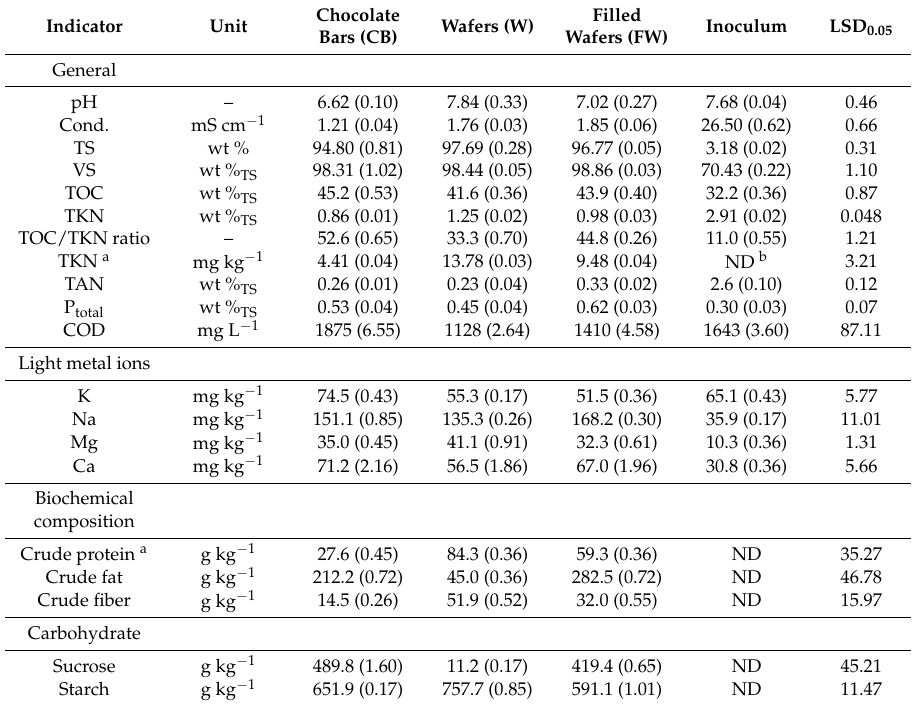
Table 1. Characteristics of substrates and inoculum (mean values, with standard deviation values in